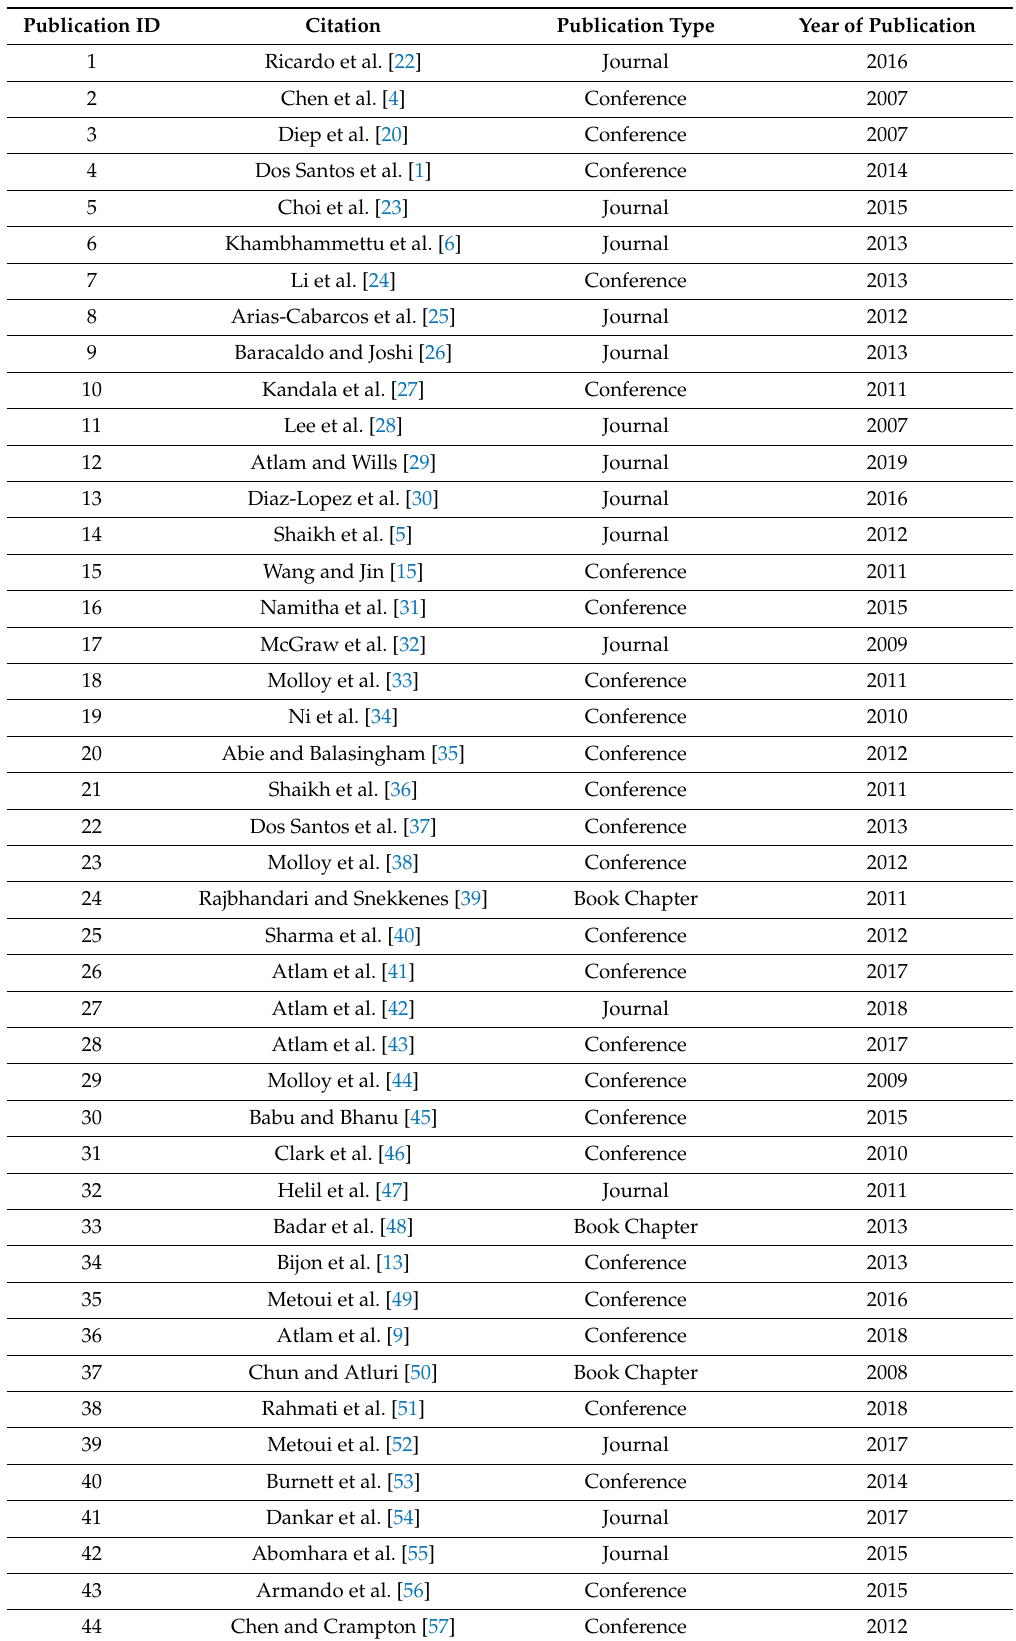
Table 3. Retrieved publications that are related to research